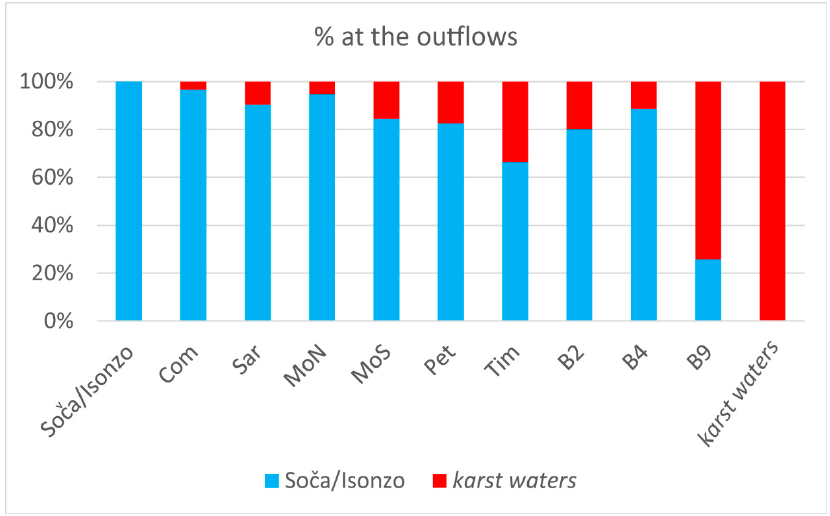
Figure 10. The mixing (%) between waters from So č a/Isonzo River (Is2) and karst waters ( effective infiltrations ) for the water samples collected during low flow conditions in September 2012.